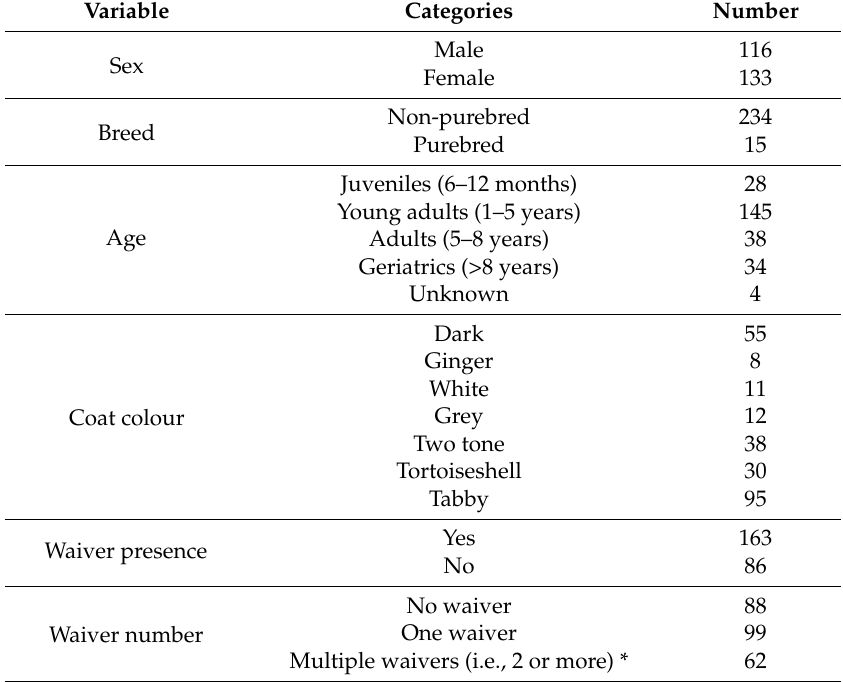
Table 3. Summary of the study cohort ( n = 249) by sex, breed, age, presence or absence of a waiver, number of waivers assigned to each cat (‘waiver number’) and waiver type. In total there were 237 waiver types analysed due to the variation in waiver number between cats (i.e., 0, 1 and